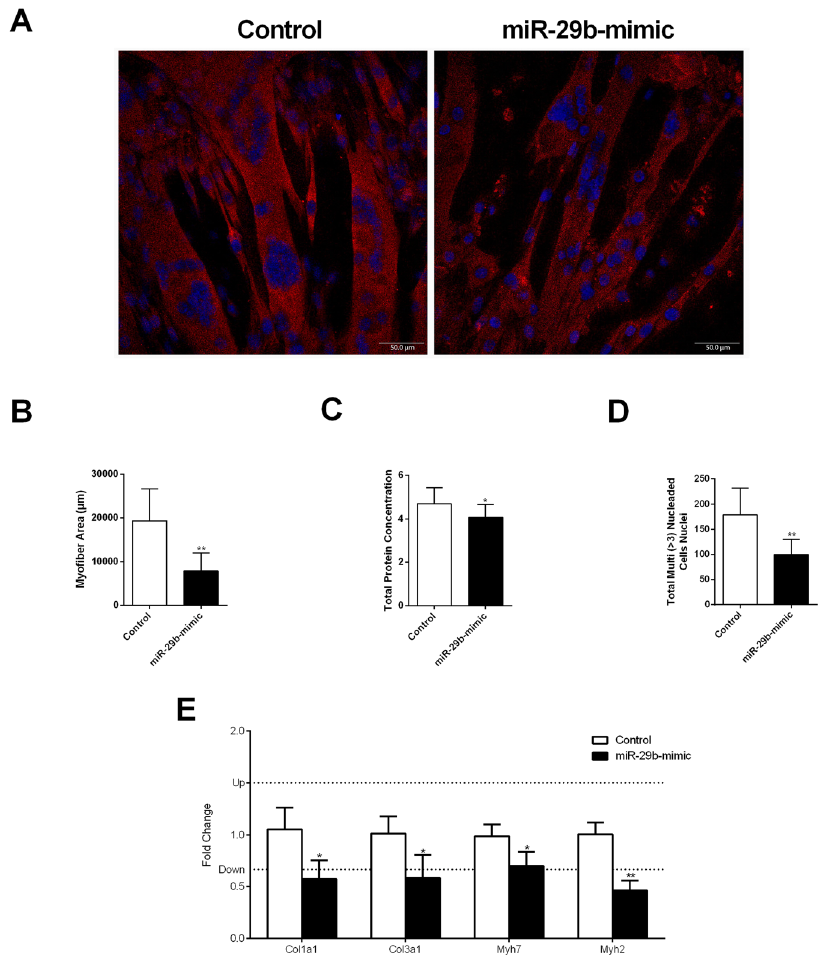
Figure 8. miR-29b promotes muscle atrophy and reduces collagens expression. Immunofluorescence of C2C12 myotubes transfected with miR-29b-3p-mimic stained with antibodies specific to myosin heavy chain Myh2 (red). Nuclei stained with DAPI (blue) (A) . Quantitative analyses of myotubes area (B) . Total protein concentration in C2C12 myotubes measured by the Bradford assay (C) . Number of total myotubes nuclei (three or more nucleus/cells) (D) . mRNA levels of Col1a1 , Col3a1 , Myh7 , and Myh2 in myotubes after miR-29b- mimic transfection compared to their levels of expression in CT, as detected by real-time PCR. The expression of each transcript was normalized by the expression of Ppia and Ppib (E) . Data represent the average of three independent experiments and are expressed as mean ± SD. * p < 0.05; ** p < 0.001: statistical significance versus CT